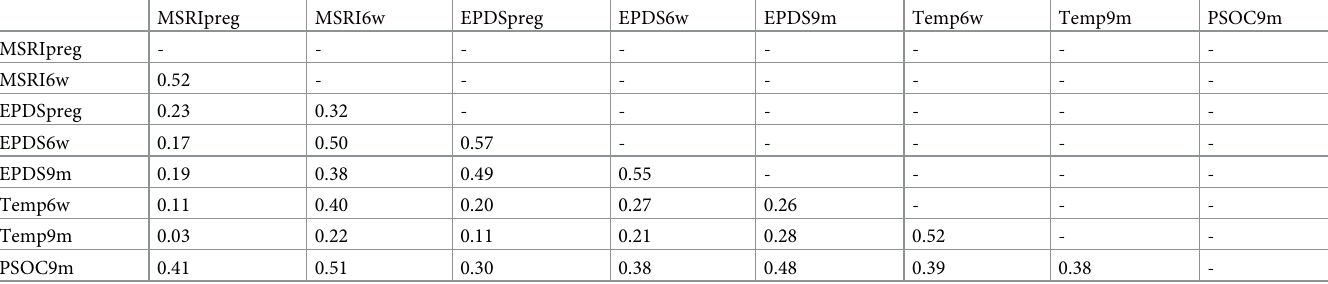
Table 3. Correlations among major variables (EPDS, MSRI, PSOC, ICQ) in the subsample used for path analysis (n = 282).